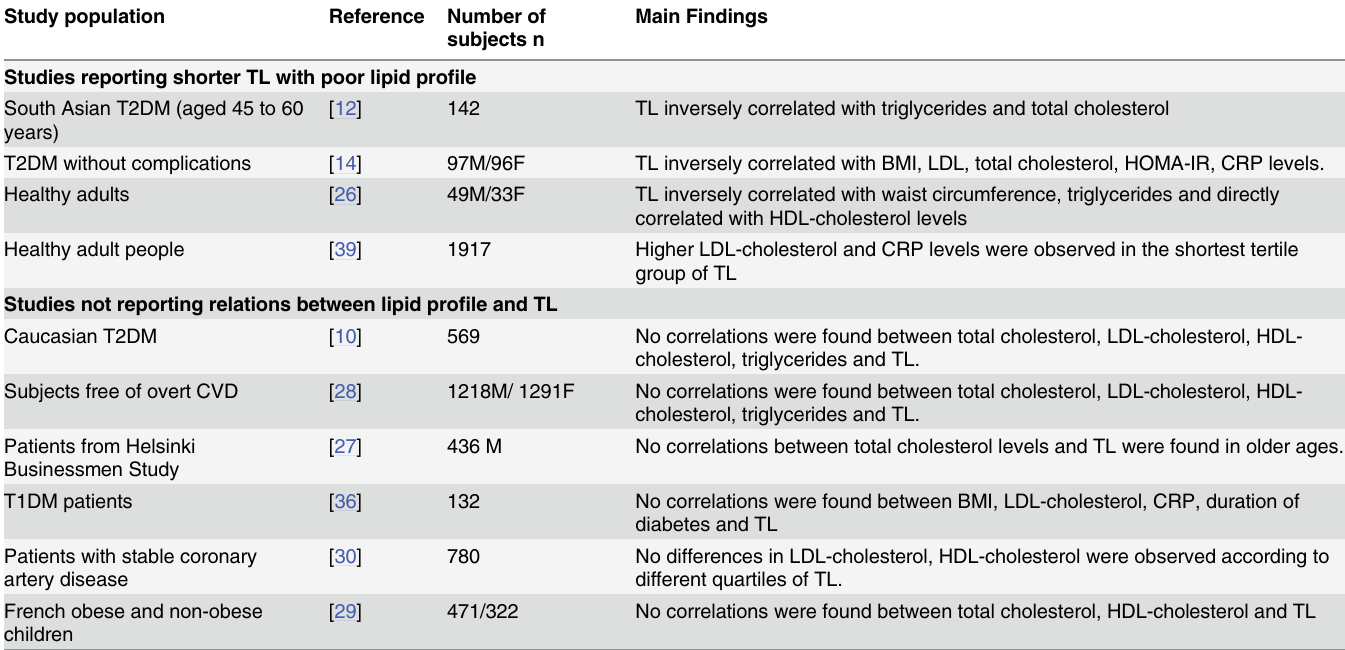
Table 3. Studies examining relationships between the telomere system and lipid related